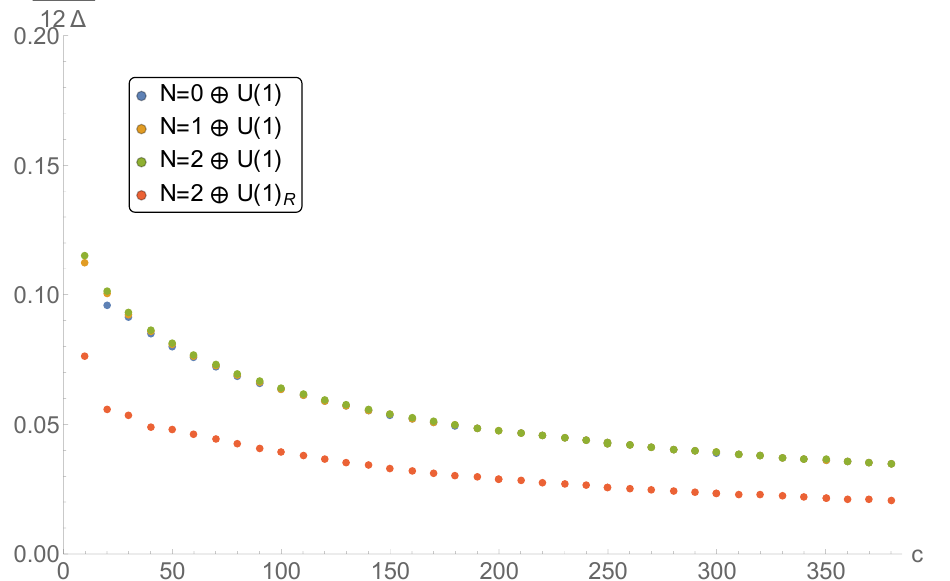
Figure 15 . Lower bounds on the charge to mass ratio. Non R-charge bounds almost overlap. Again, the level of U(1) current was normalized by